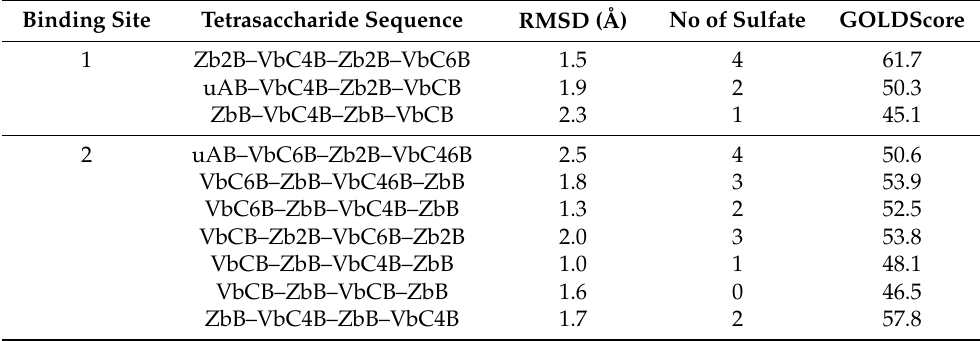
Table 2. CS tetrasaccharide (CS04) sequences from the library of 192 sequences that satisfied the dual-filter CVLS strategy for TGF- β 2.